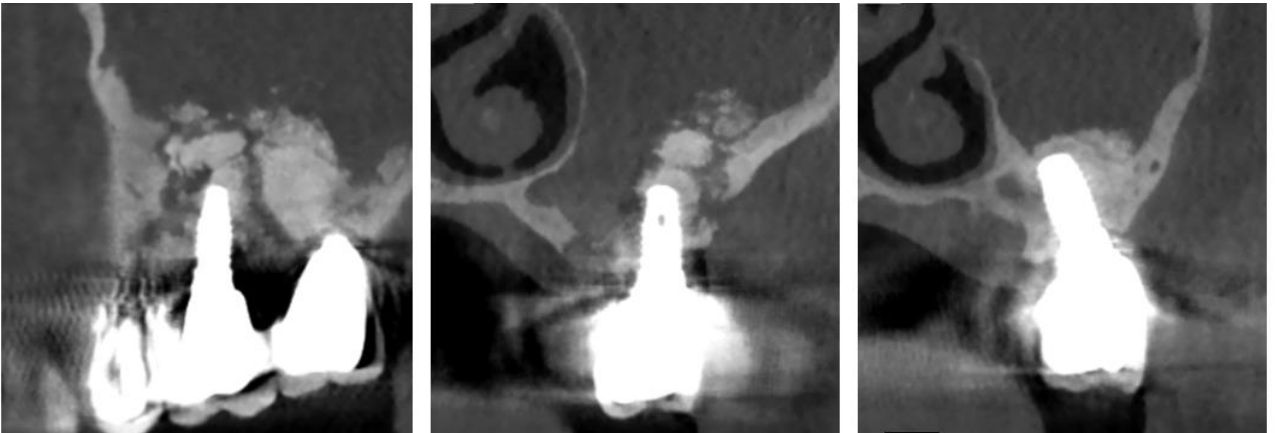
Figure 1. Preoperative CBCT showing a spontaneous bisphosphonates related osteonecrosis of the (upper) jaw in a patient with multiple myeloma treated with zoledronic acid (4 mg × 18 doses).